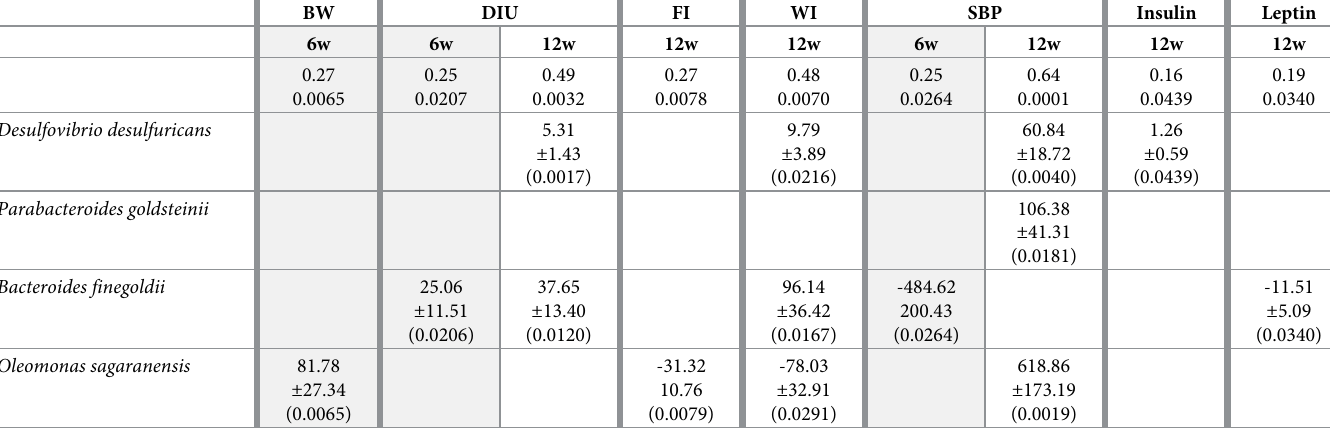
Table 5. Regression fits for each of the physiological variables studied using as independent variables those species that show significant differences between butter and virgin olive oil enriched diets.